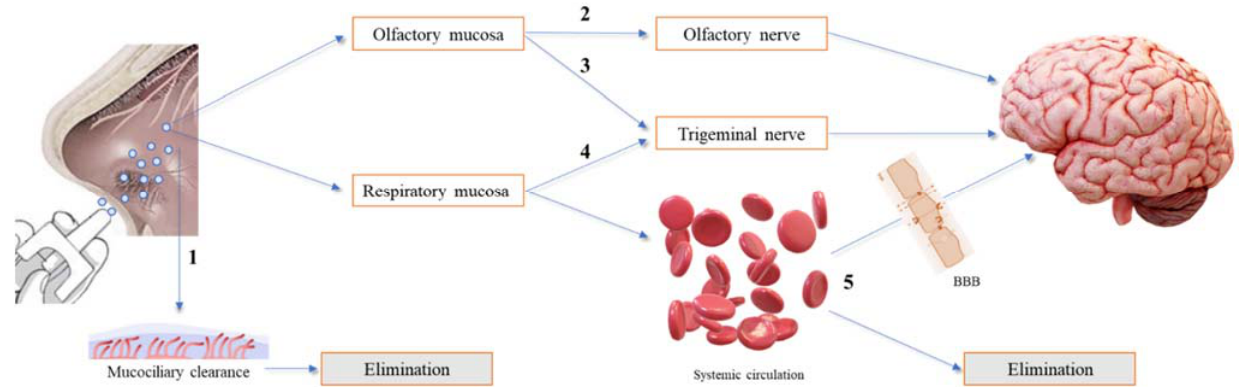
Figure 2. Overview of the different drug pathways after nasal administration. (1) The drug is eliminated by the mucociliary clearance mechanism. (2) The drug reaches the olfactory mucosa, passes through the olfactory nerve, via intraneuronal and/or extraneuronal transport, and reaches the brain. (3) The drug reaches the olfactory mucosa, passes through the trigeminal nerve and reaches the brain via the cribriform plate. (4) The drug reaches the respiratory mucosa, passes through the trigeminal nerve and reaches the brainstem. (5) The drug reaches the respiratory mucosa, is absorbed into the systemic circulation, and diverges between passage to the brain, upon crossing the blood − brain barrier (BBB), and elimination, before reaching the brain.